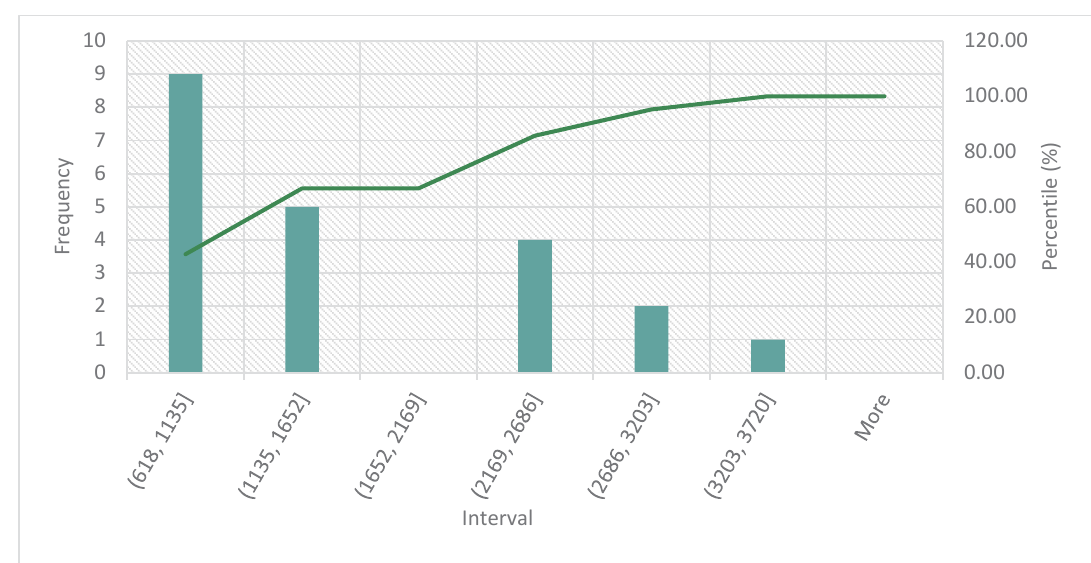
Fig. 2: Histogram and Pareto Graphic for TN Polk County